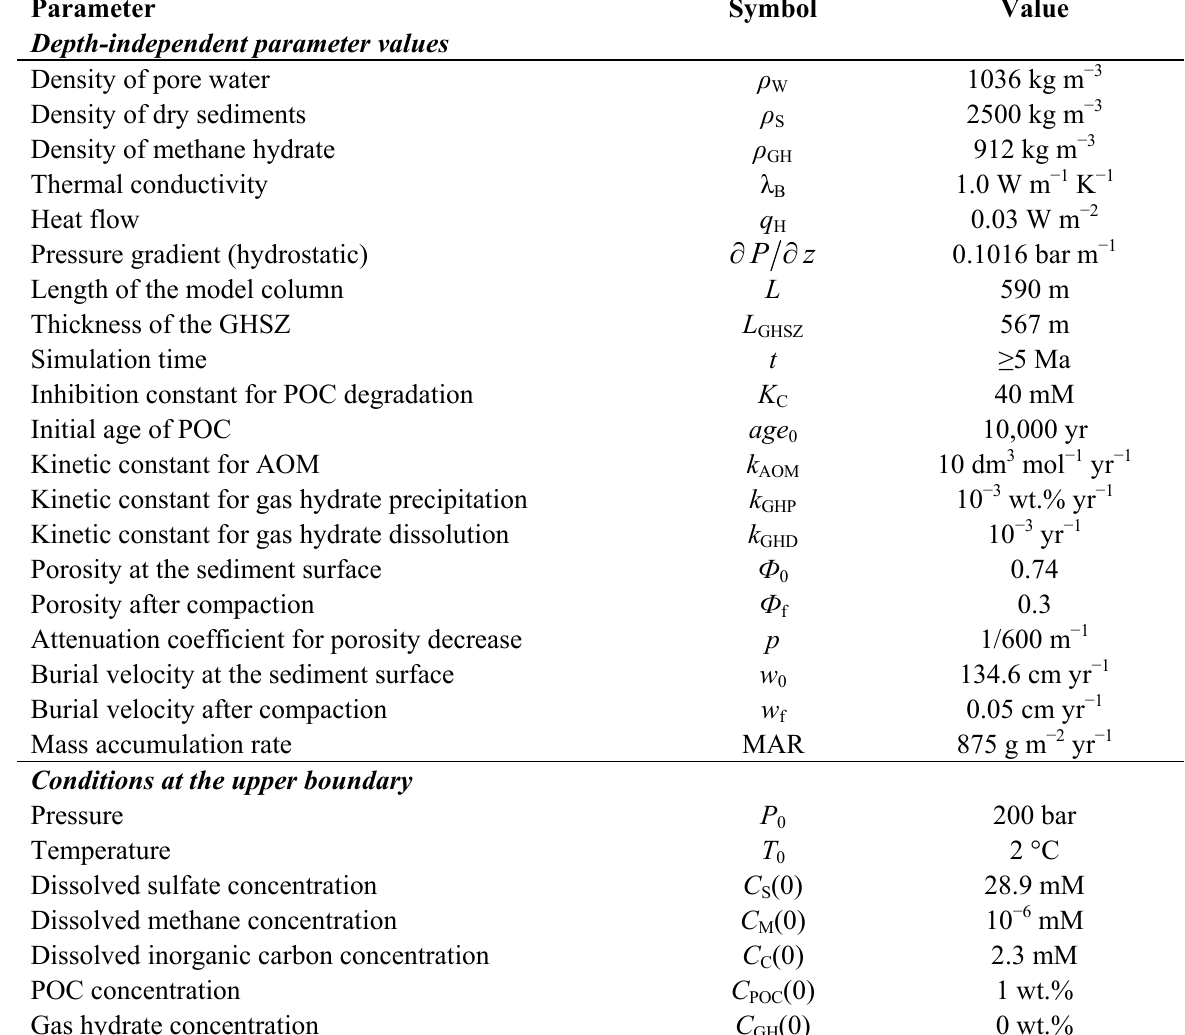
Table 2. Parameter values and upper boundary conditions applied in the reference